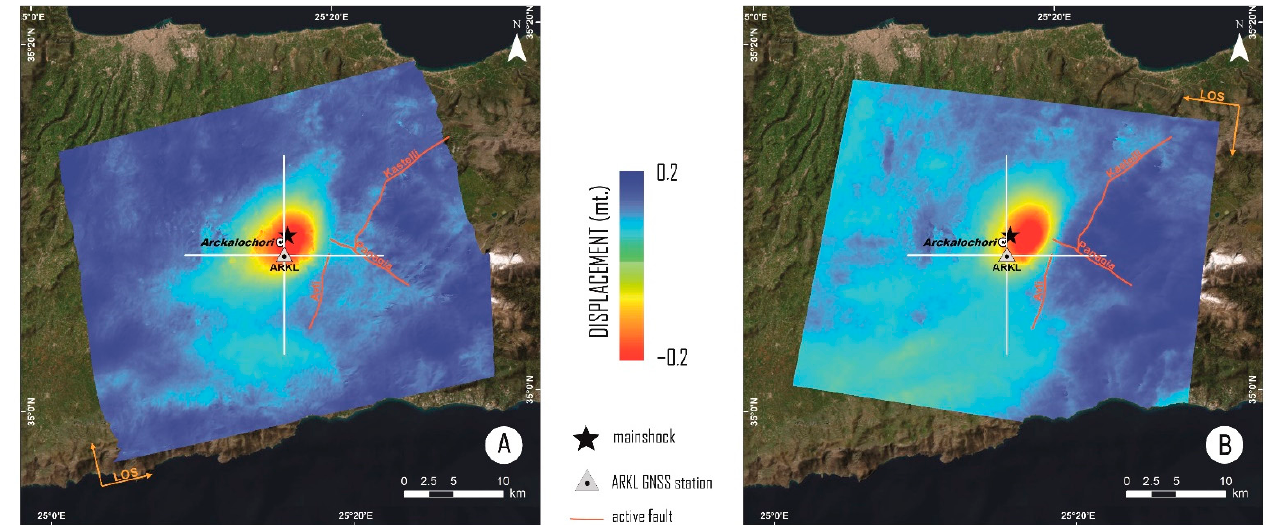
Figure 4. Ascending ( A ) and descending ( B ) displacements. The mainshock is highlighted with a black star.